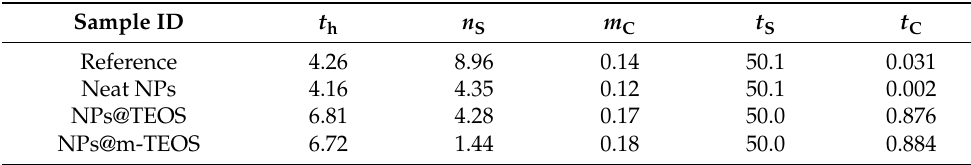
Figure 9. Sedimentation curves for the reference MR fluid (white squares) and its bidisperse ana- logues supplemented with the neat NPs (black squares), NPs@TEOS (red circles) and NPs@m-TEOS (blue triangles) in ( a ) low viscosity (15 mPa · s) oil and ( b ) high viscosity (100 mPa · s) oil; the solid lines mark the best fit of the 5P S-model. The section ( c ) shows the digital images of the MR fluids based on low viscosity oil at two different sedimentation periods. The color of each stopper denotes the type of the sample, as per legend in ( a ) section. Table 2. Numerical fitting results for the 5P